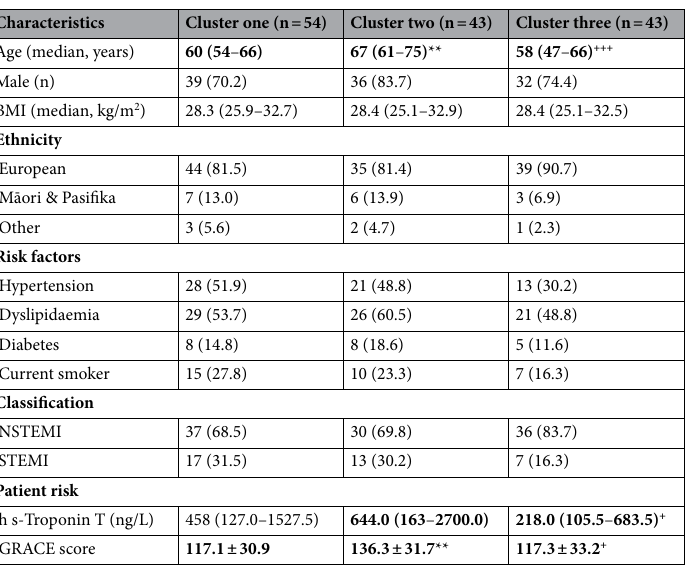
Table 4. Patient demographics and clinical characteristics of clustered groups. Significant differences are shown in bold. Continuous variables are reported as median (IQR). Kruskal–Wallis test with Dunn’s correction for multiple comparisons was used to compare continuous variables between clusters. *denotes significance compared to Cluster 1. + denotes significance compared to Cluster 2. ** p < 0.01, + p < 0.05, +++ p < 0.001. Categorical variables are reported as frequency (percentage). Chi Square test was used to determine differences in categorical variables between